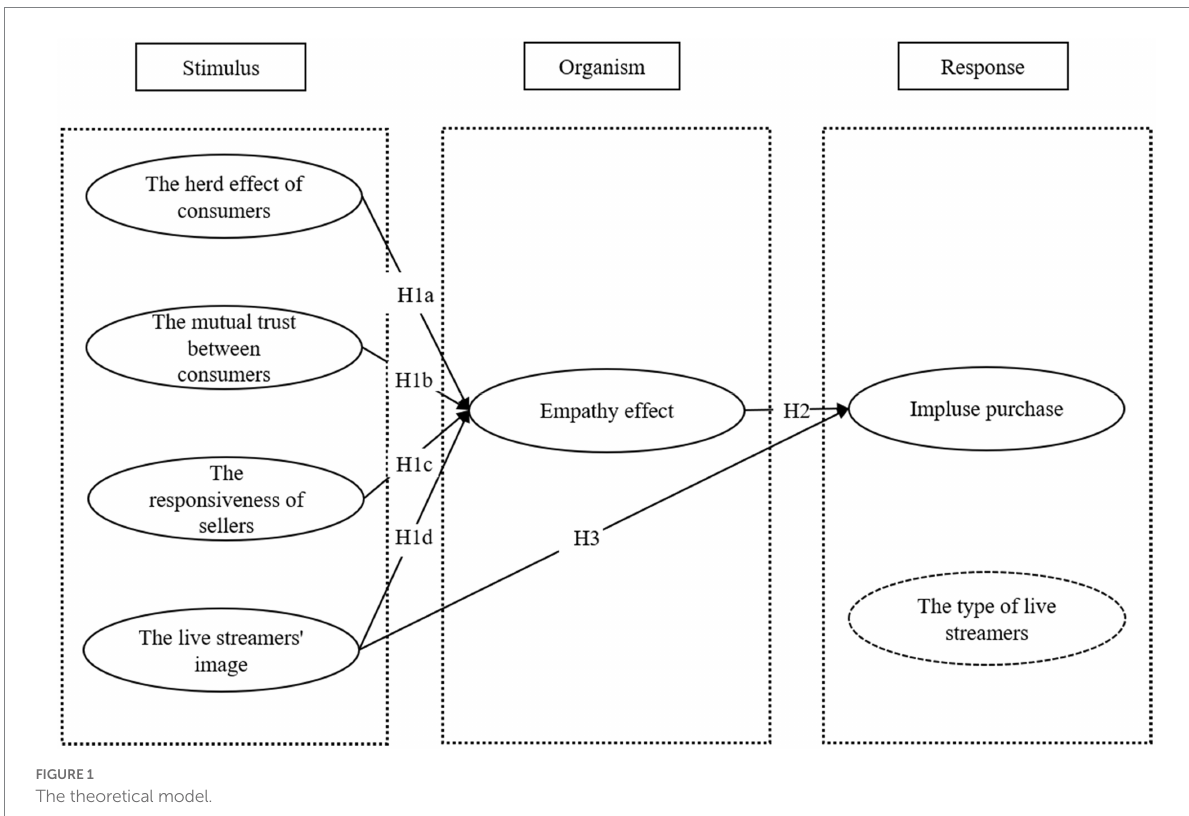
FIGURE 1 The theoretical